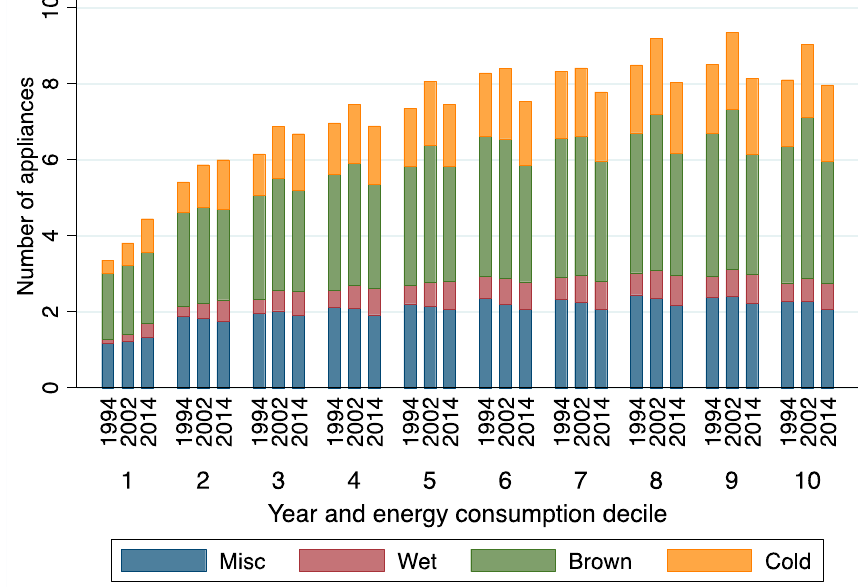
Figure 6. Number of appliances by electrical consumption decile and end-uses. Mexico, 1992, 2002, and 2014. Source: Authors’ calculations, ENIGH (1992–2014).